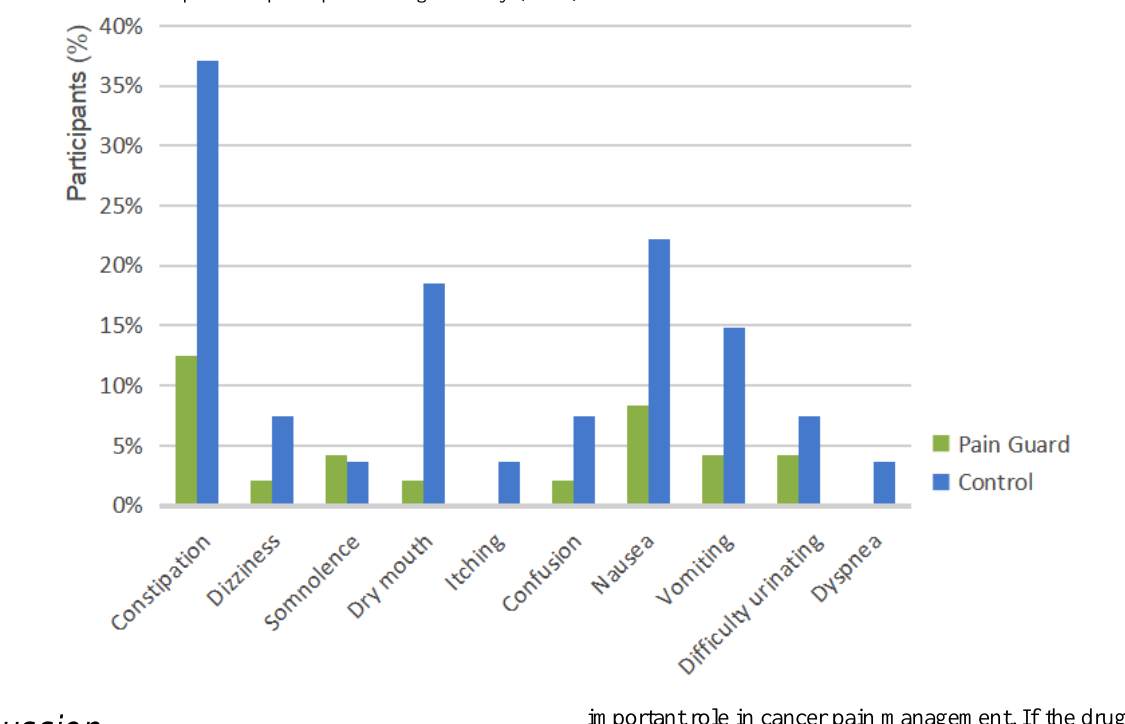
Figure 9. Adverse reactions profile of participants during the study